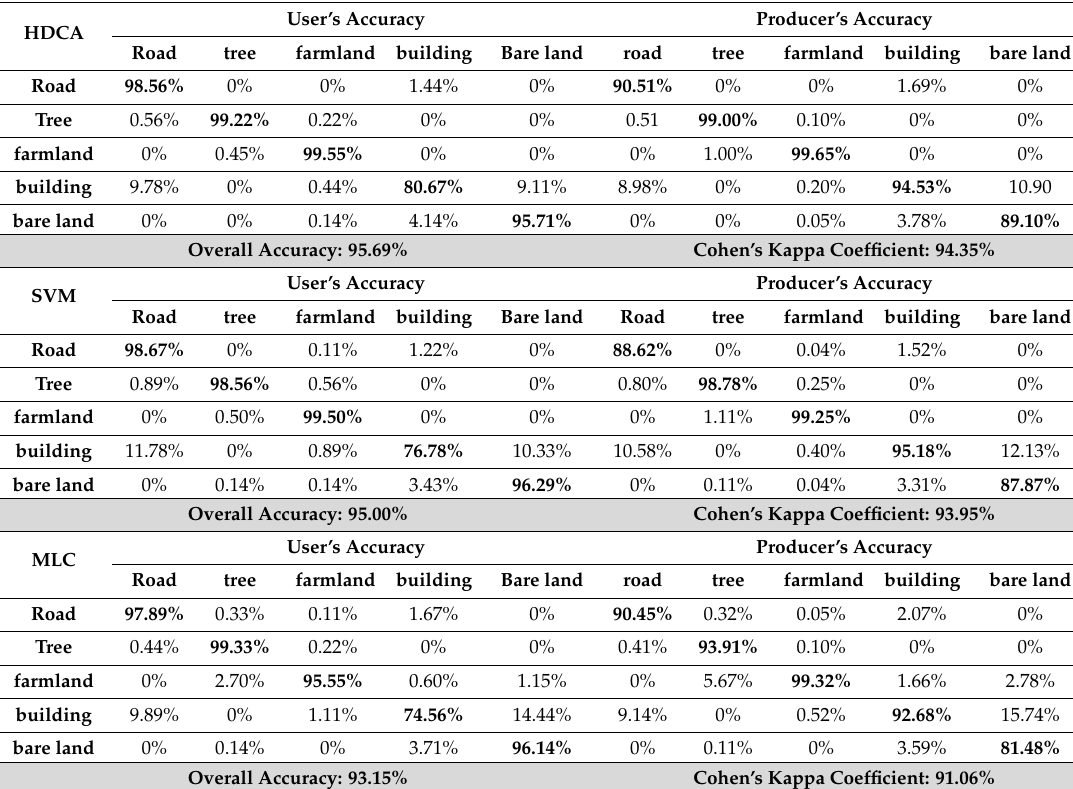
Table 1. User’s and Producer’s accuracy, Overall accuracy and Cohen’s Kappa of three classifiers. User’s Accuracy Producer’s Accuracy HDCA